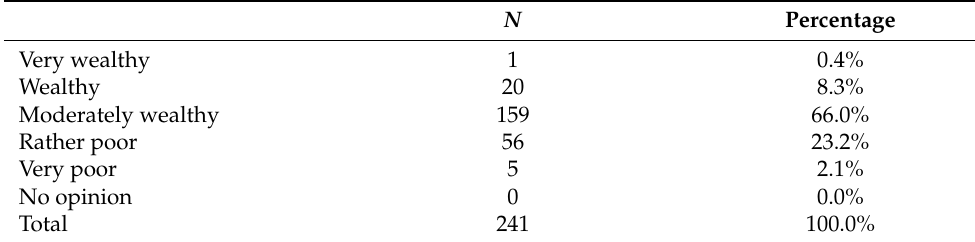
Table 4. General assessment of the commune’s financial situation.